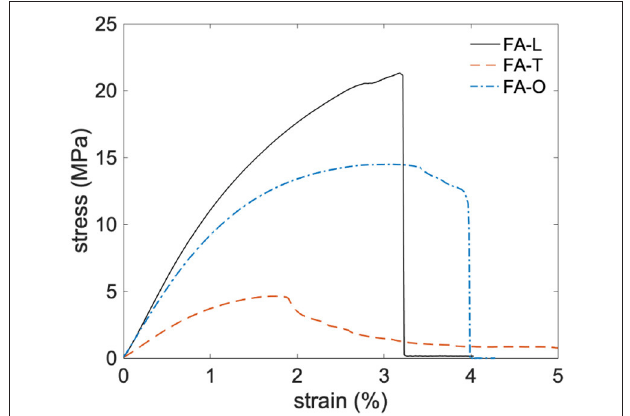
FIGURE 7 | Representative stress-strain curves from quasi-static tensile tests of the sample FA (all the three considered directions). to which the ultrathin laminae are subjected during cutting.